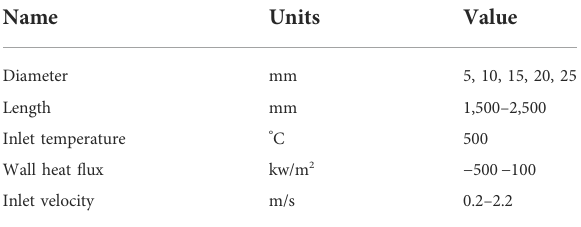
TABLE 5 Geometry and numerical calculation boundary conditions. TABLE 6 Grid independence veri fi